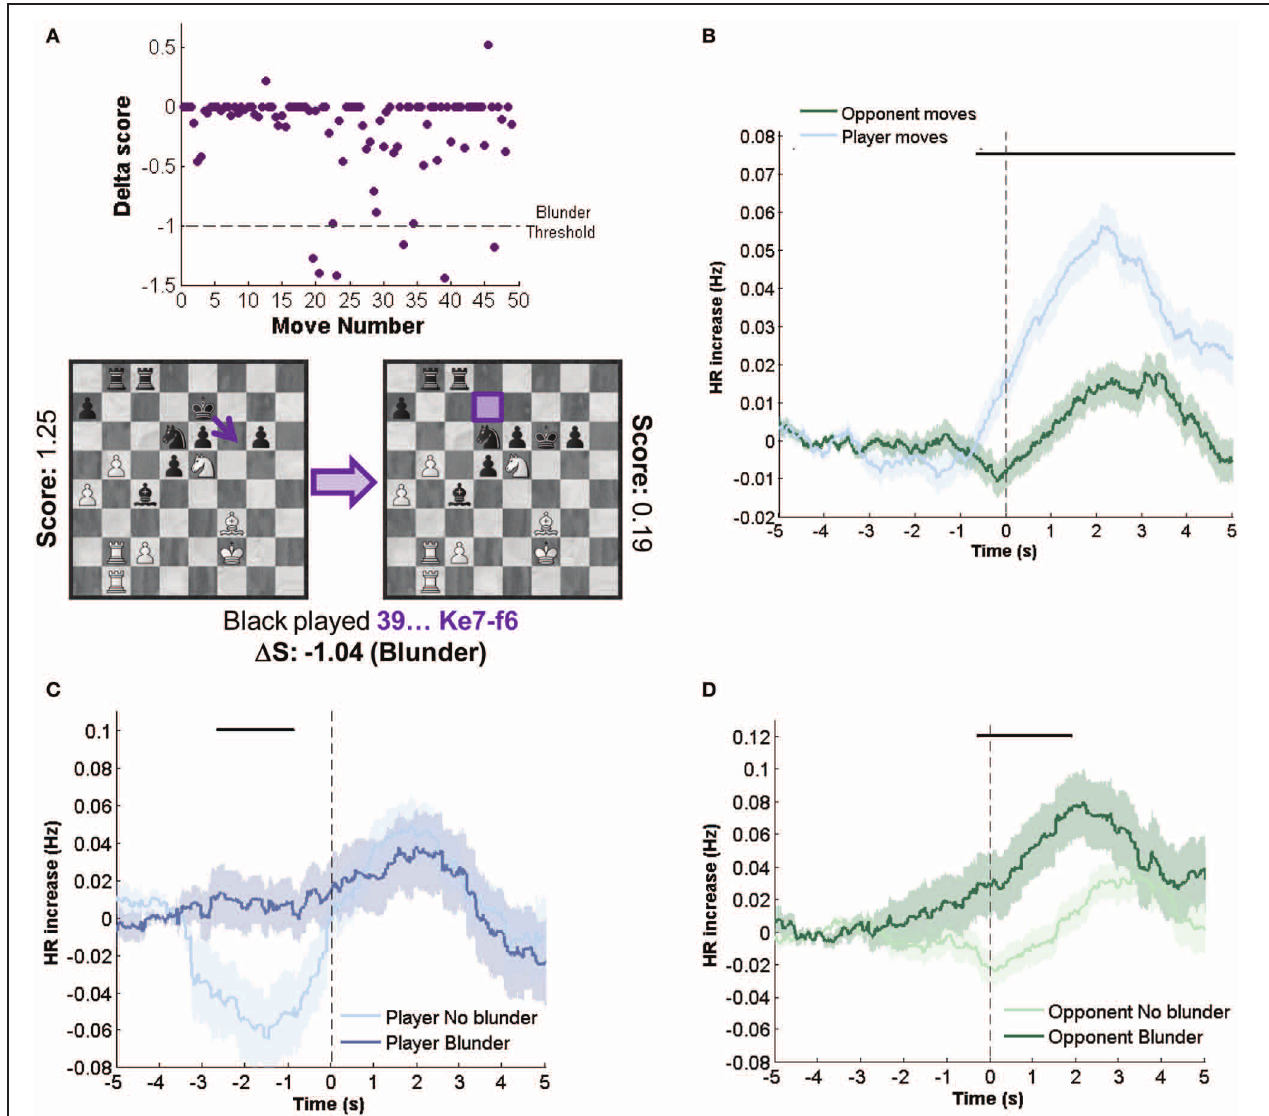
FIGURE 2 | HR indexes objective errors and this depends on which player did the move. (A) Upper panel: Delta Score ( (cid:2) S ) variation with move number for a typical game ( (cid:2) S ≤ − 1 is a blunder). Lower panel, an example of two chess positions before and after a blunder or error move. Note that black’s move allows white to fork the king and rook with the knight. (B) Temporal course of HR dynamics on own and